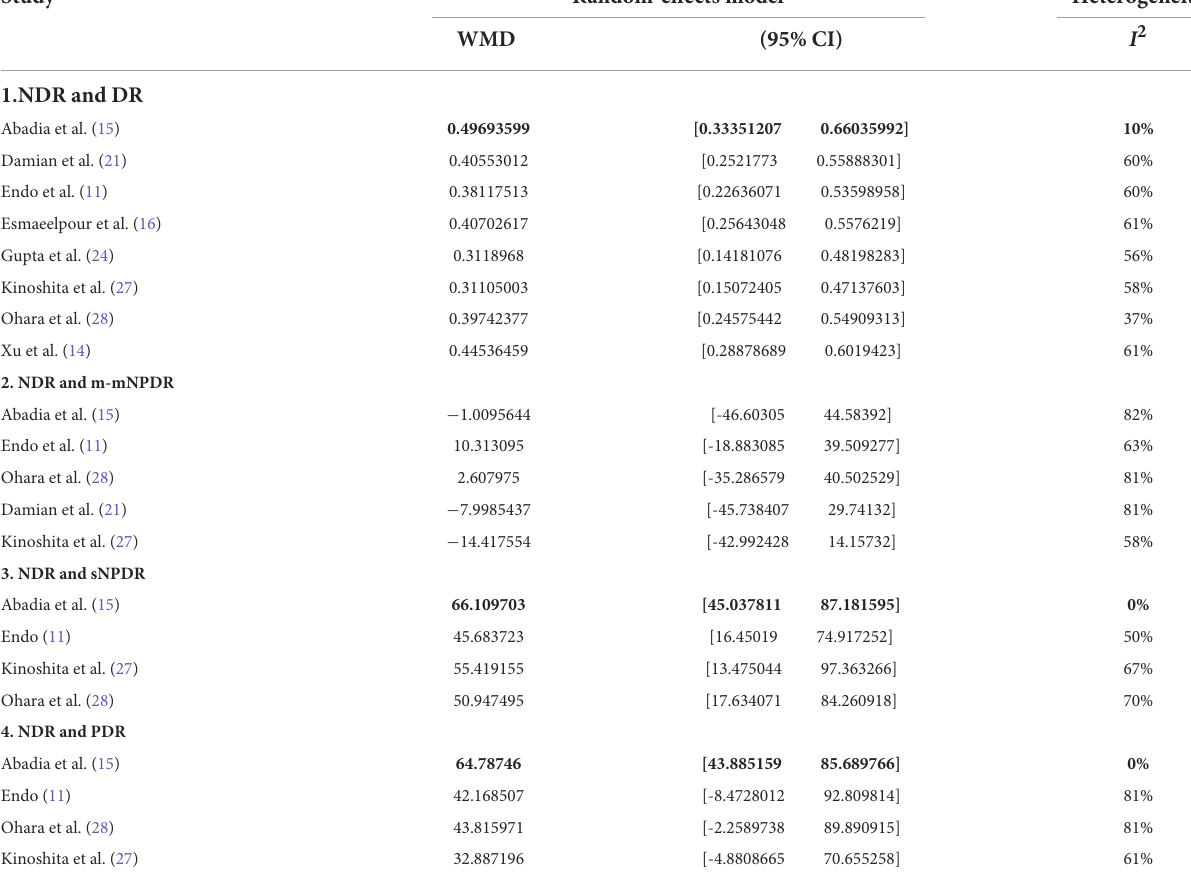
TABLE 3 Sensitivity analysis of SFCT in DR